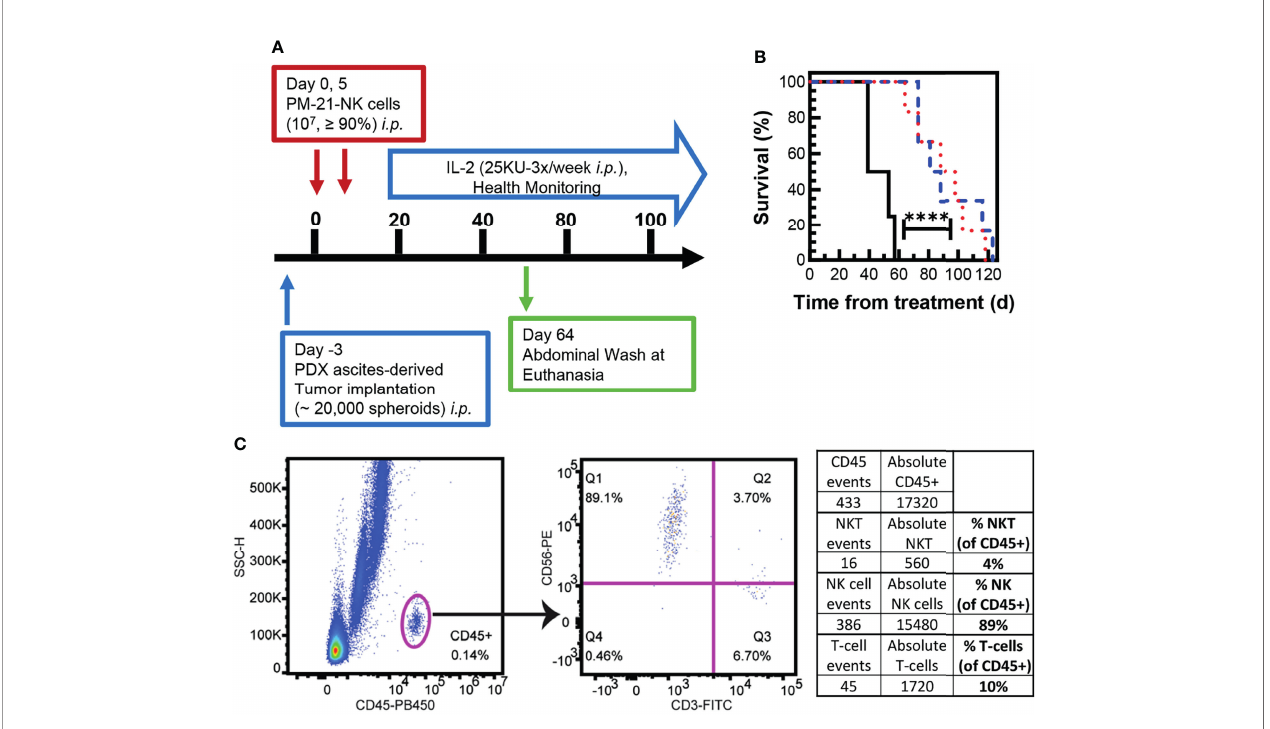
FIGURE 7 | Cryopreserved NK cells exert antitumor effect in an in vivo PDX mouse model. Ascites were collected from an NSG mouse that had PDX tumor injected intraperitoneally. Spheroids were obtained from the ascites, and 20,000 spheroids were injected in suspension back to the intraperitoneal ( i.p. ) cavity of female NSG mice and allowed to seed for 3 days. Mice were then treated with 2 doses of cryopreserved NK cells (1 × 10 7 /dose, days 0 and 5) from two donors, which were thawed and directly injected i.p. along with IL-2 (25,000 U, 3×/week). Health was monitored periodically, and abdominal wash was collected from one mouse treated with frozen NK cells euthanized 64 days posttreatment. A schematic of the experiment is shown (A) . Mice injected with frozen NK cells from donor 1 (blue dashed line) and donor 2 (red dotted line) had a signi fi cant increase in survival compared to untreated mice (black solid line) (B) . Flow cytometry dot plots are shown for gating on CD45+ cells in the abdominal wash of a treated mouse euthanized on day 64 posttreatment (C) . The percentages of hNKT (CD3 + , CD56 + ), hNK (CD3 - , CD56 + ), and hT cells (CD3 + ) were determined in the hCD45 + population. Statistical signi fi cance was determined by comparing survival curves using the Gehan – Breslow – Wilcoxon